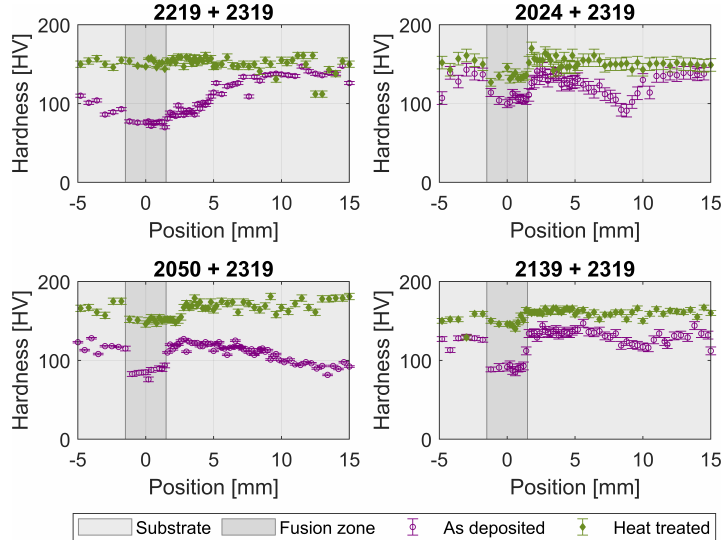
Figure 3. Hardness profile of the heat affected zone, measured 1 mm under the substrate top surface.